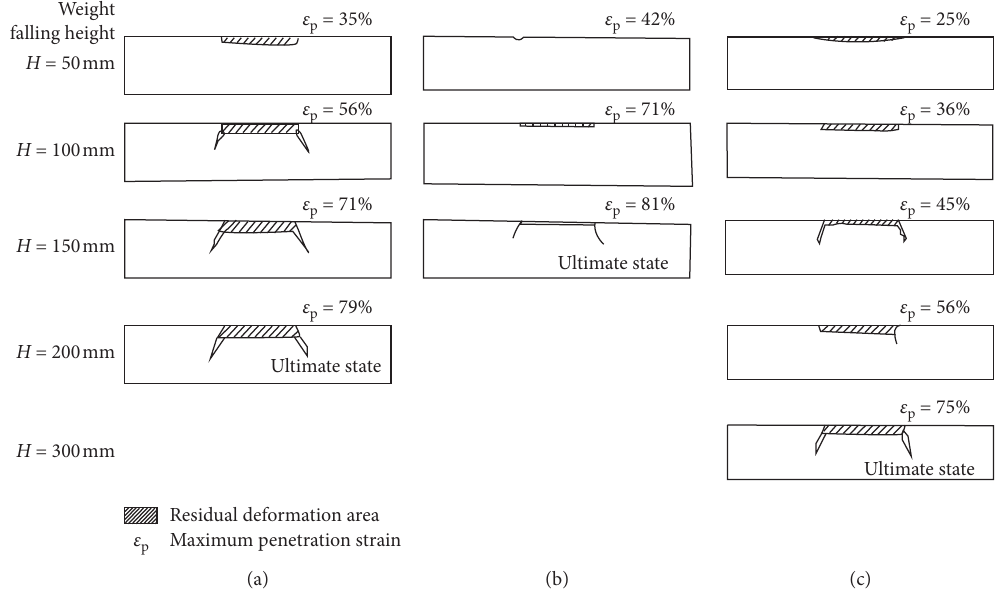
Figure 5: State of expanded material cut area in the case of material without core slabs. (a) ST. (b) PP. (c) EST.